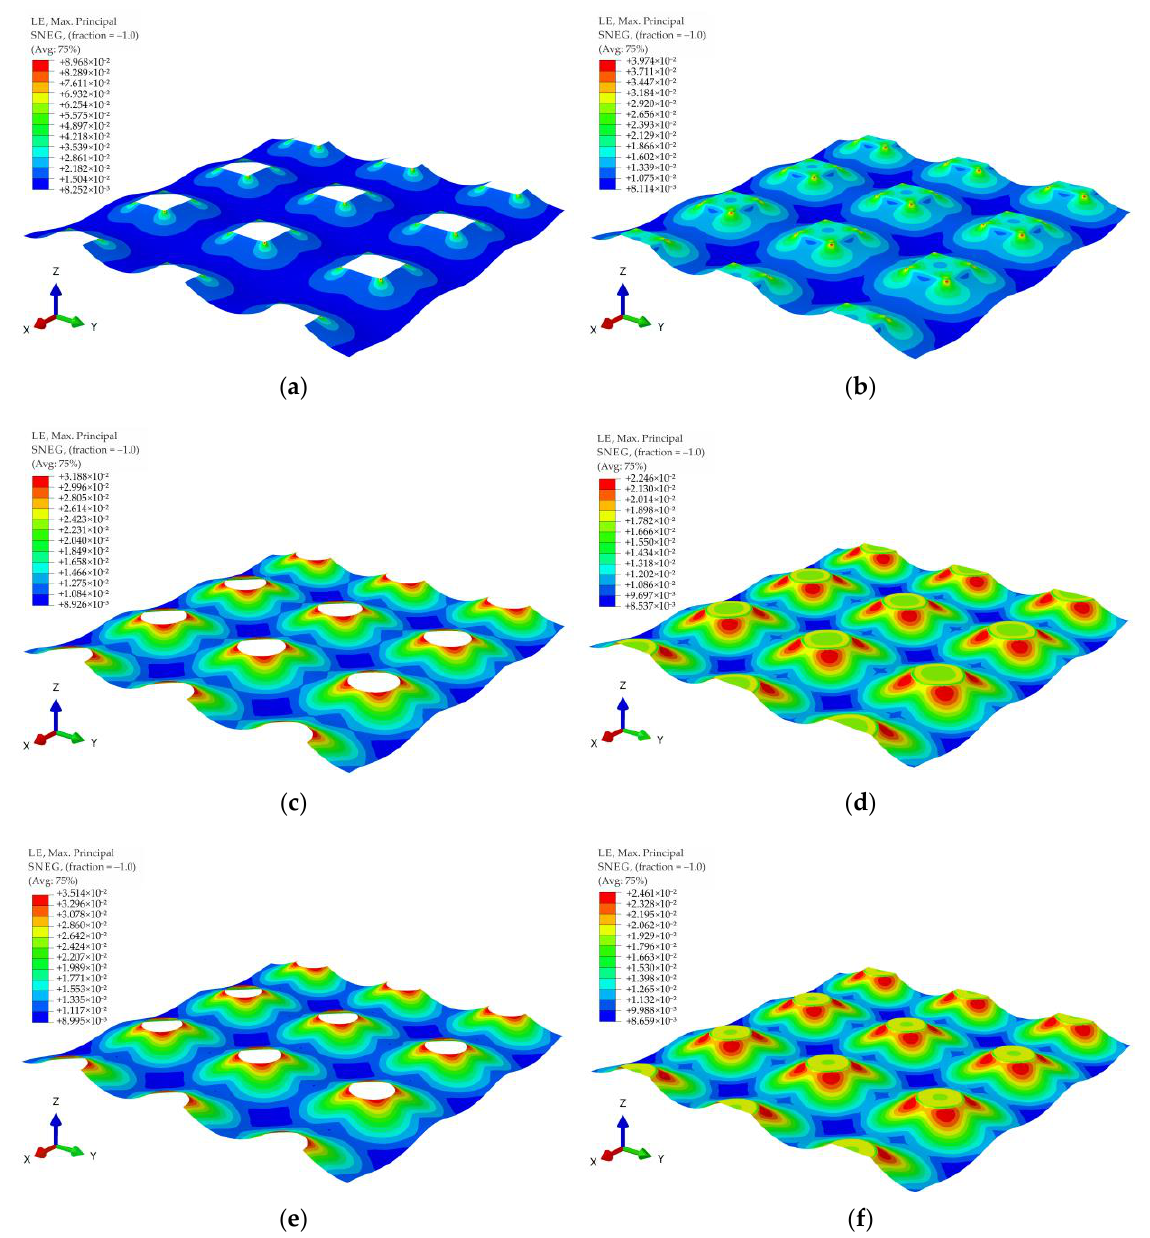
Figure 15. Membrane deformation and maximum principal strains for J = 1615 kN/m and v = 0.3: ( a ) variant A1; ( b ) variant A2; ( c ) variant B1; ( d ) variant B2; ( e ) variant C1; ( f ) variant C2.